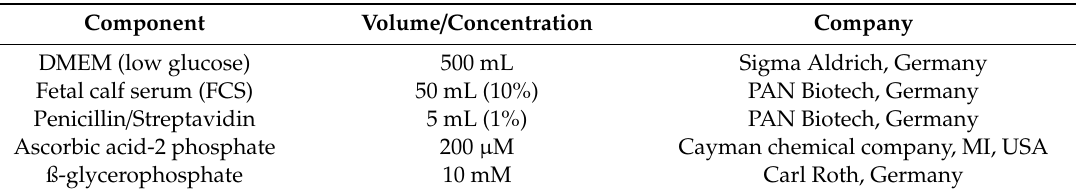
Table 2. Osteogenic di ff erentiation medium.